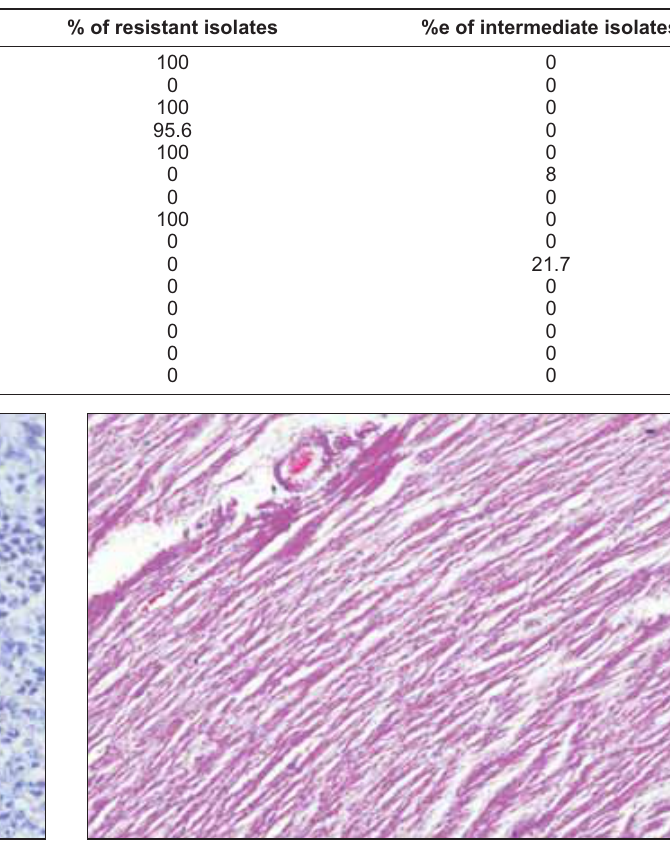
Figure-4: Microphotograph showing presence of thrombi in blood vessel of